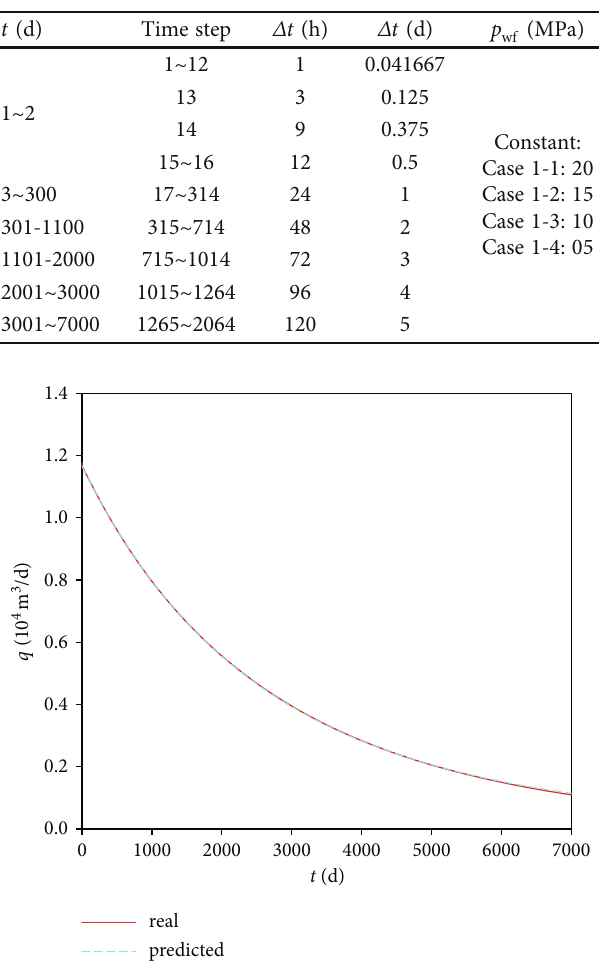
Table 2: Production schedules for the numerical cases with normal pressure at constant